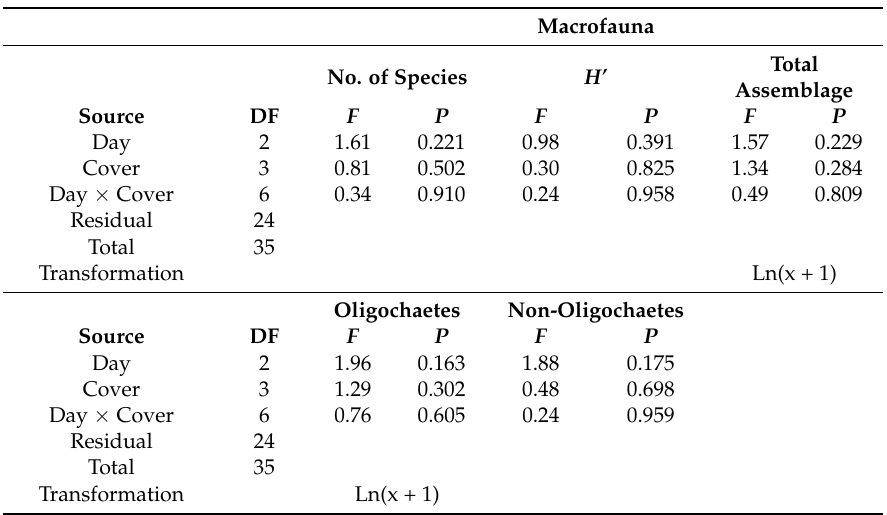
Table 6. ANOVA results for macrofauna in traps: number of species, H’ , and absolute dispersal rates (ADRs). Transformations indicated where